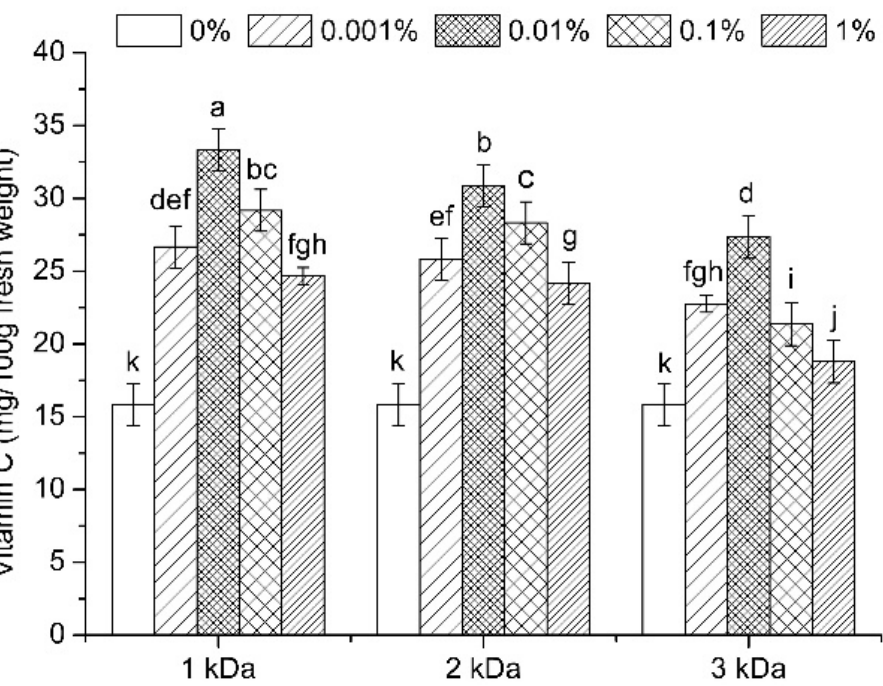
Figure 1. Vitamin C content of soybean sprouts under different chitooligosaccharide treatments. The treatments were conducted with chitooligosaccharides of three molecular weights (1, 2, and 3 kDa) at four different concentrations (0.001 to 1%). The control treatment (0%) included the same solutions without chitooligosaccharides. Vertical bars represent the standard error of three replicates. Different letters indicate statistically significant difference ( p < 0.05).